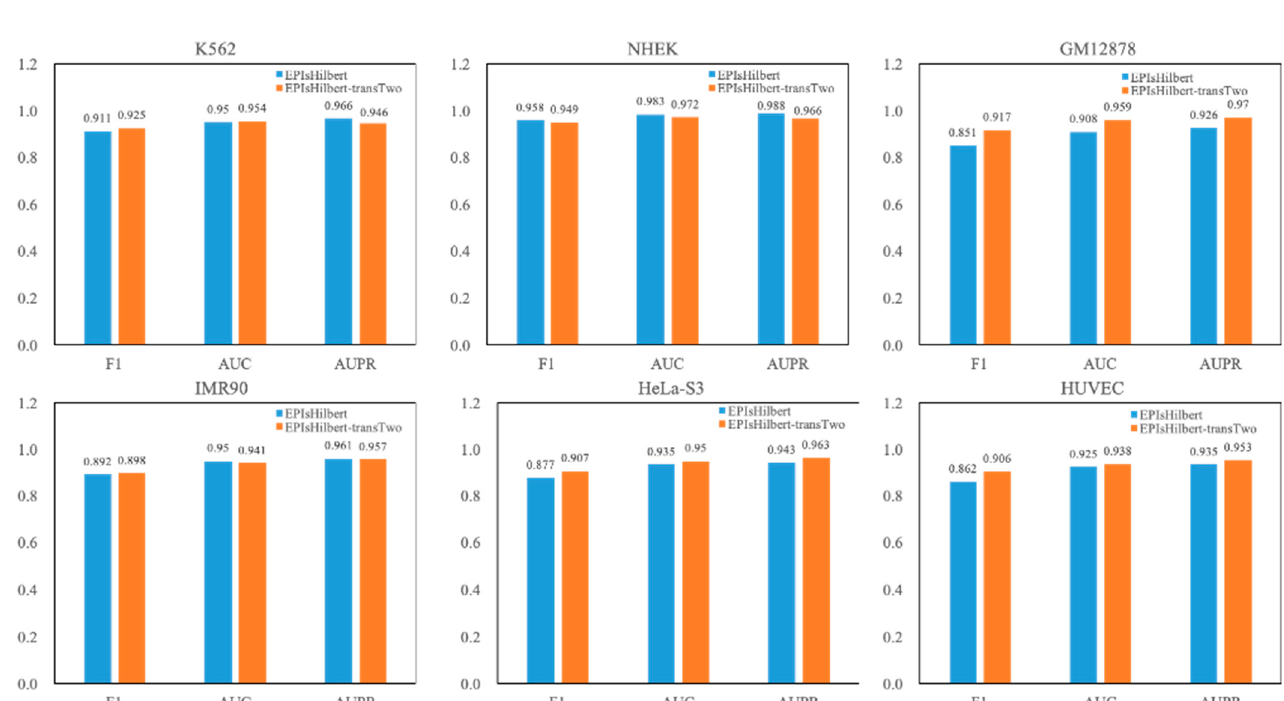
Figure 4. The comparison between EPIsHilbert and EPIsHilbert-transTwo.